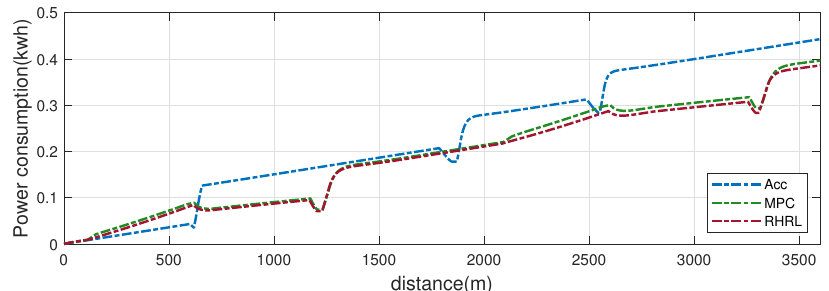
Figure 14. Energy consumption in distance